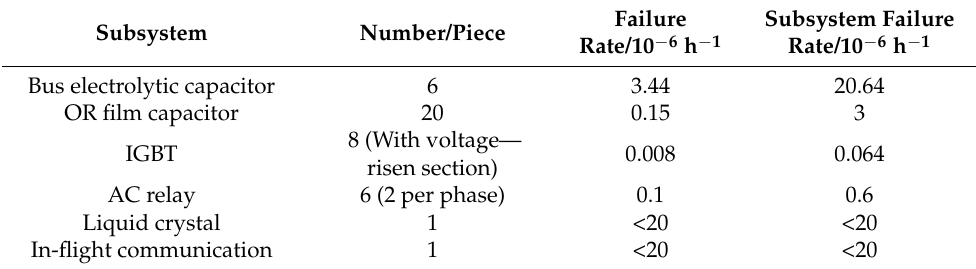
Table 3. Failure rates of sub-system and total failure rates.